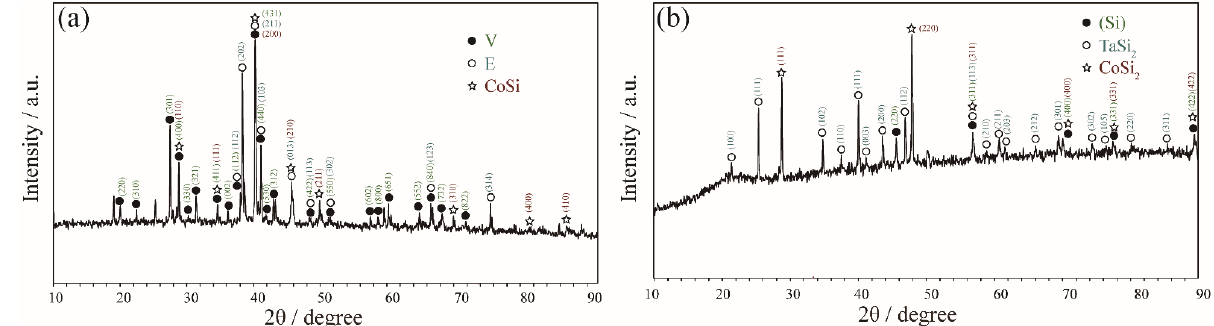
Figure 2. Typical ternary micrograph images obtained of ( a ) Co 34 Ta 26 Si 40 alloy annealed at 1100 °C